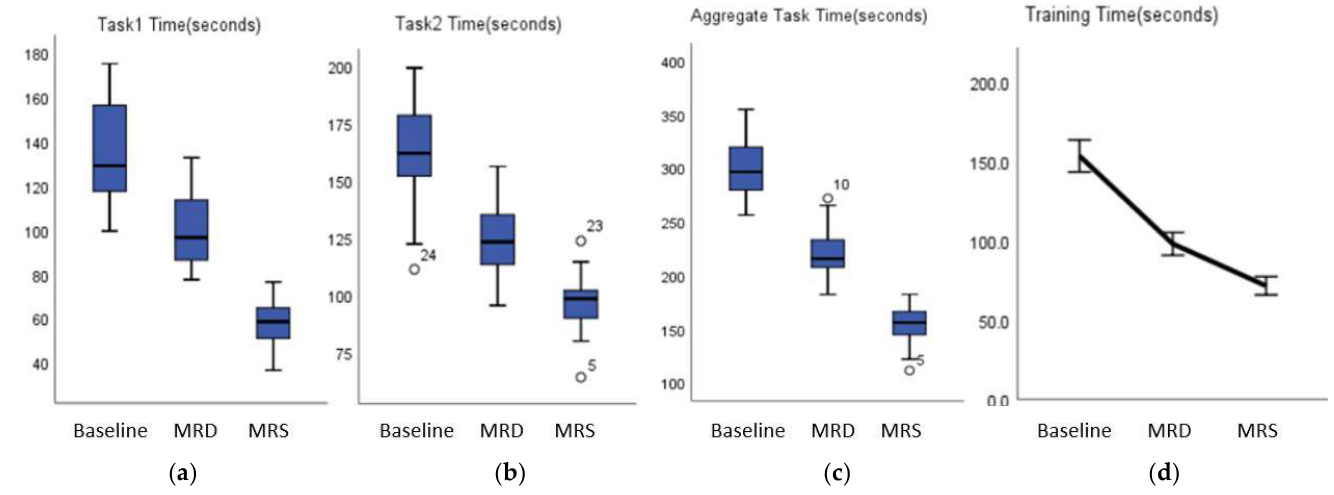
Figure 5. Boxplots of quantitative measures on the user performance for each HRI scheme across two manipulation tasks. ( a ) Time to complete the pick-and-place tasks; ( b ) the assembly task completion time; ( c ) the aggregate task completion time; ( d ) the mean training completion time. MRD and MRS denote MR SpaceMouse and MR subspace, respectively.